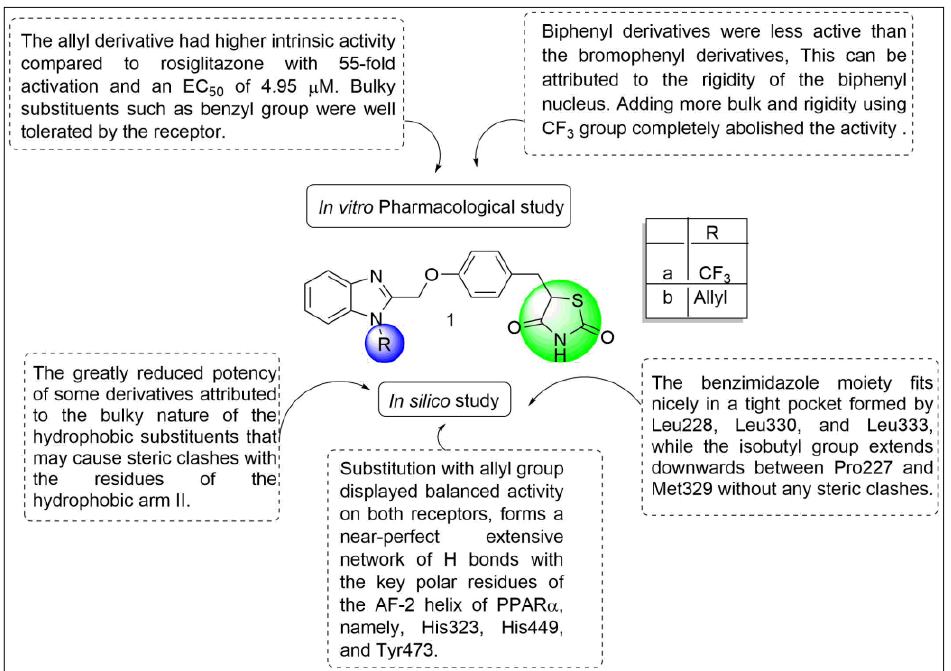
Figure 6. Structural activity relationship of thiazolidinediones hybrids ( 1 ) as potent PPAR ligands.